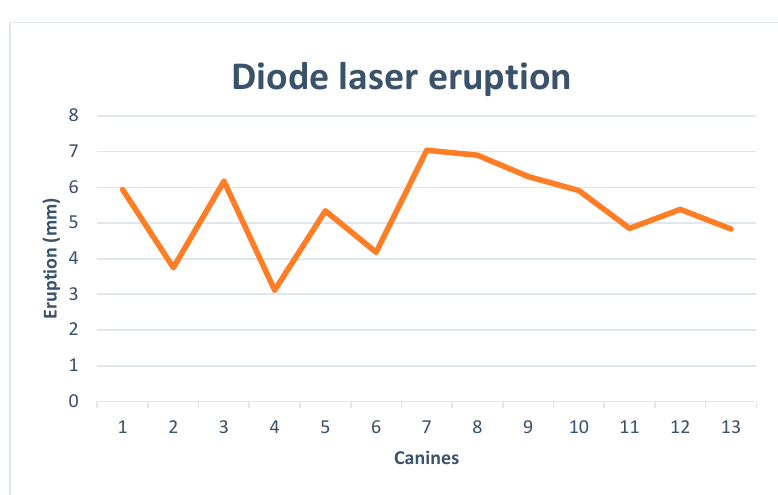
Figure 9. CO 2 laser eruption values.